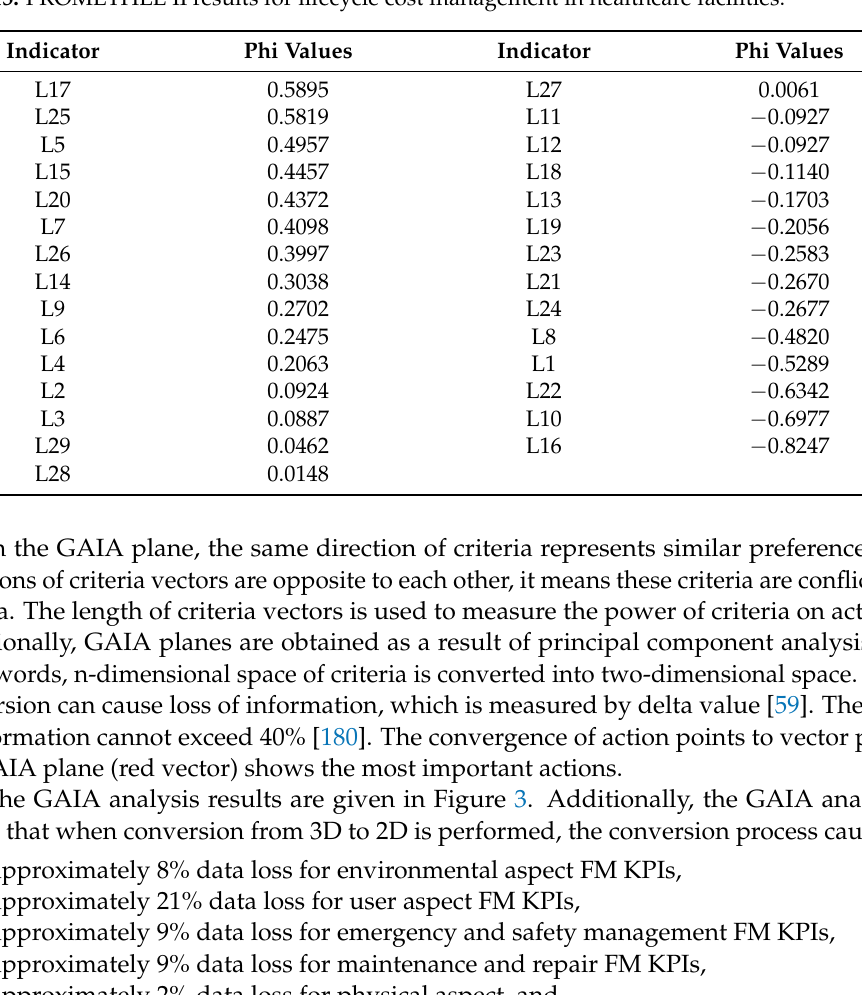
Table 15. PROMETHEE II results for lifecycle cost management in healthcare